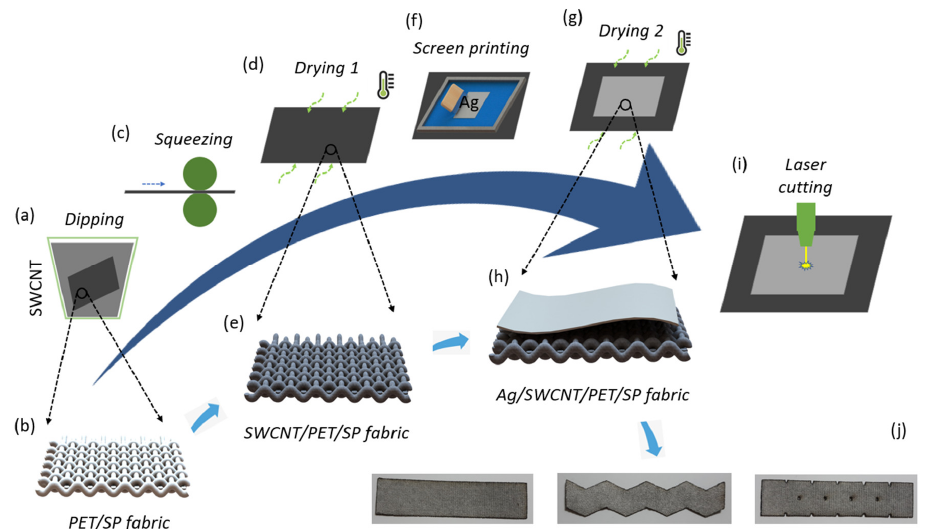
Figure 1. Manufacturing process from polyester/spandex (PET/SP) fabric consisting of ( a ) dipping single-walled carbon nanotubes (SWCNTs), ( b ) PET / SP fabrics, ( c ) squeezing, ( d ) drying SWCNT, single-walled carbon nanotubes (SWCNTs), ( b ) PET/SP fabrics, ( c ) squeezing, ( d ) drying SWCNT, ( e ) ( e ) SWCNT fabrics, ( f ) screen printing Ag pastes, ( g ) drying Ag / SWCNT, ( h ) Ag / SWCNT fabrics, ( i ) laser SWCNT fabrics, ( f ) screen printing Ag pastes, ( g ) drying Ag/SWCNT, ( h ) Ag/SWCNT fabrics, ( i ) cutting, ( j ) the di ff erent shapes of Ag / SWCNT laser cutting, ( j ) the different shapes of Ag/SWCNT sensors.